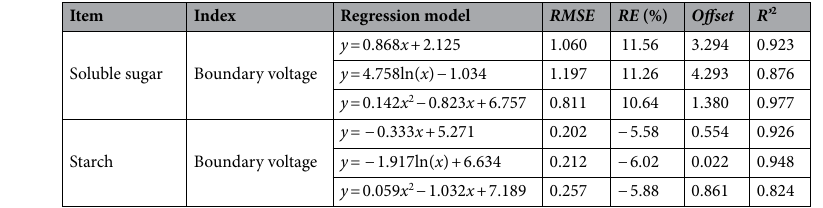
Table 2. Indexes for assessing the fitting of measured and predicted values of soluble sugar and starch contents.